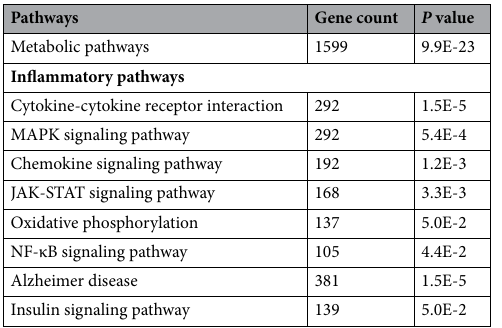
Table 1. KEGG-GO pathways of altered genes in APP/PS1/Sirt3 -/- (comorbid-AD) mice. The significance of enrichment ( P value) is shown in the